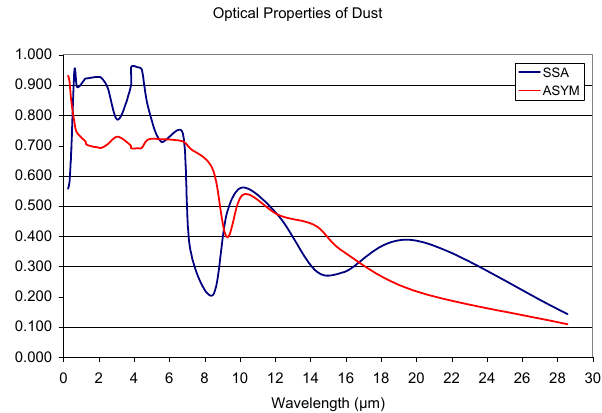
Fig. 1. Single scattering albedo (SSA – blue line) and asymmetry parameter (ASYM – red line) of dust particles used in this